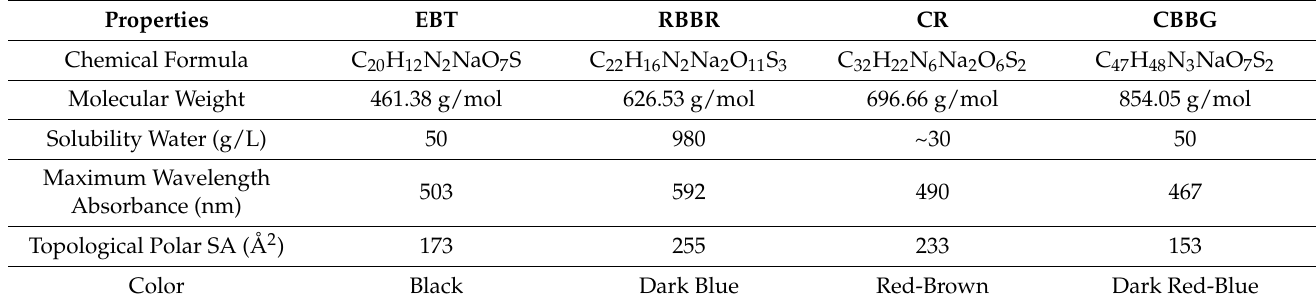
Table 1. Summary of the physiochemical properties of the dyes